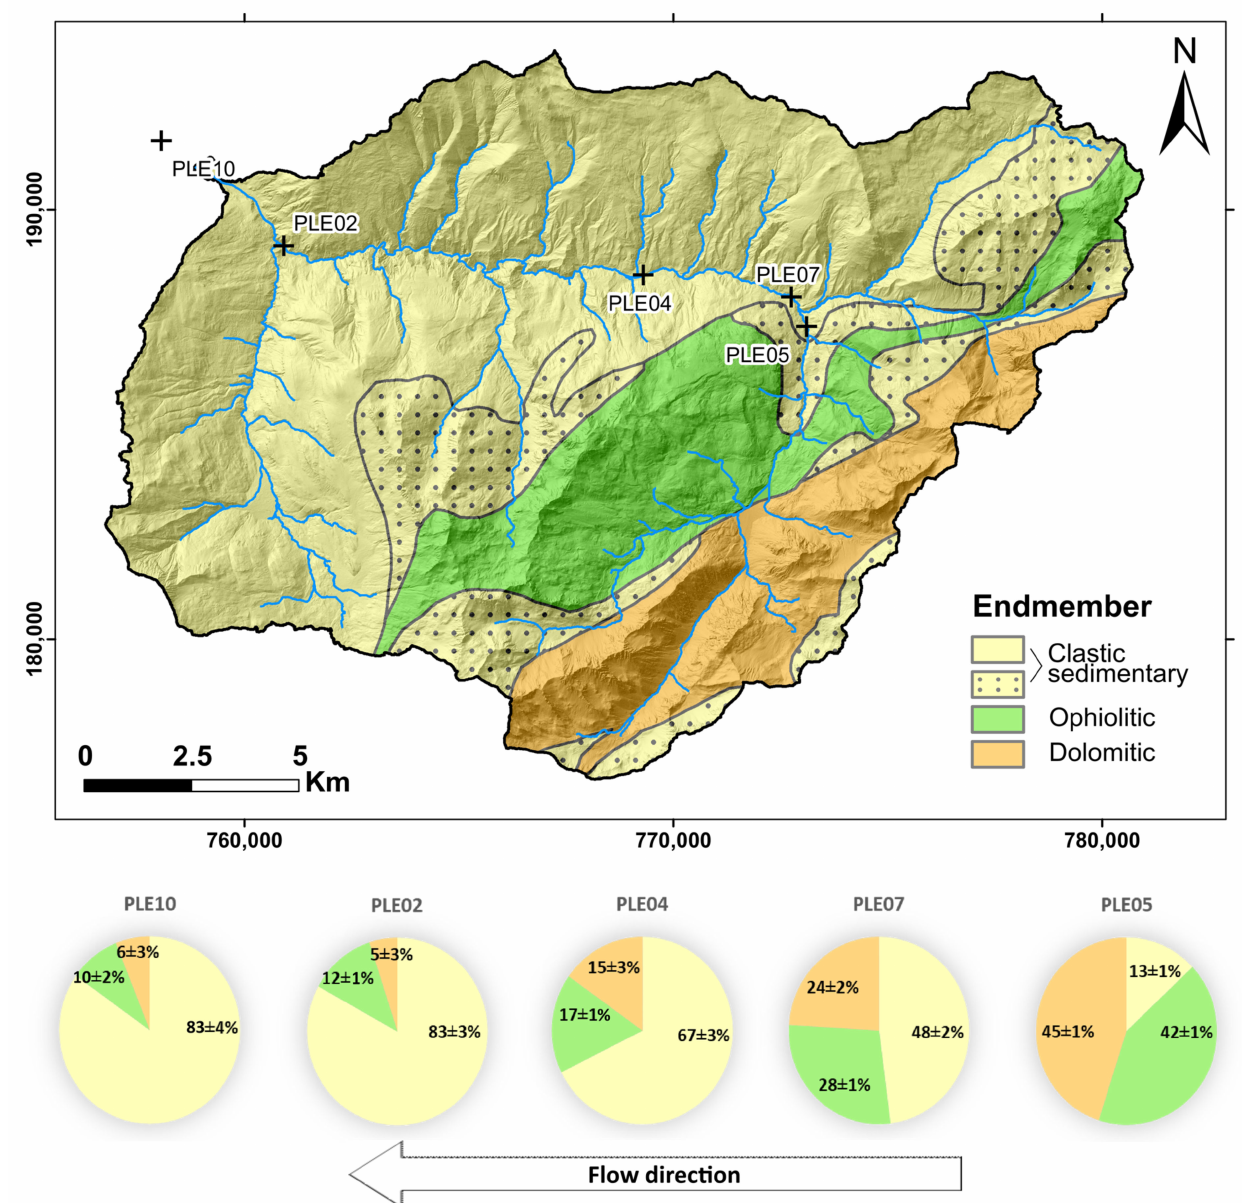
Figure 11. Sediment provenance considering three endmembers (Clastic sedimentary, Ophiolitic, and Dolomitic) and calculated for five in-stream samples (PLE02, PLE04, PLE05, PLE07, and PLE10). The results were obtained using the model run 2 of Table 4. The numbers at the border of the figure indicate the Swiss coordinates in